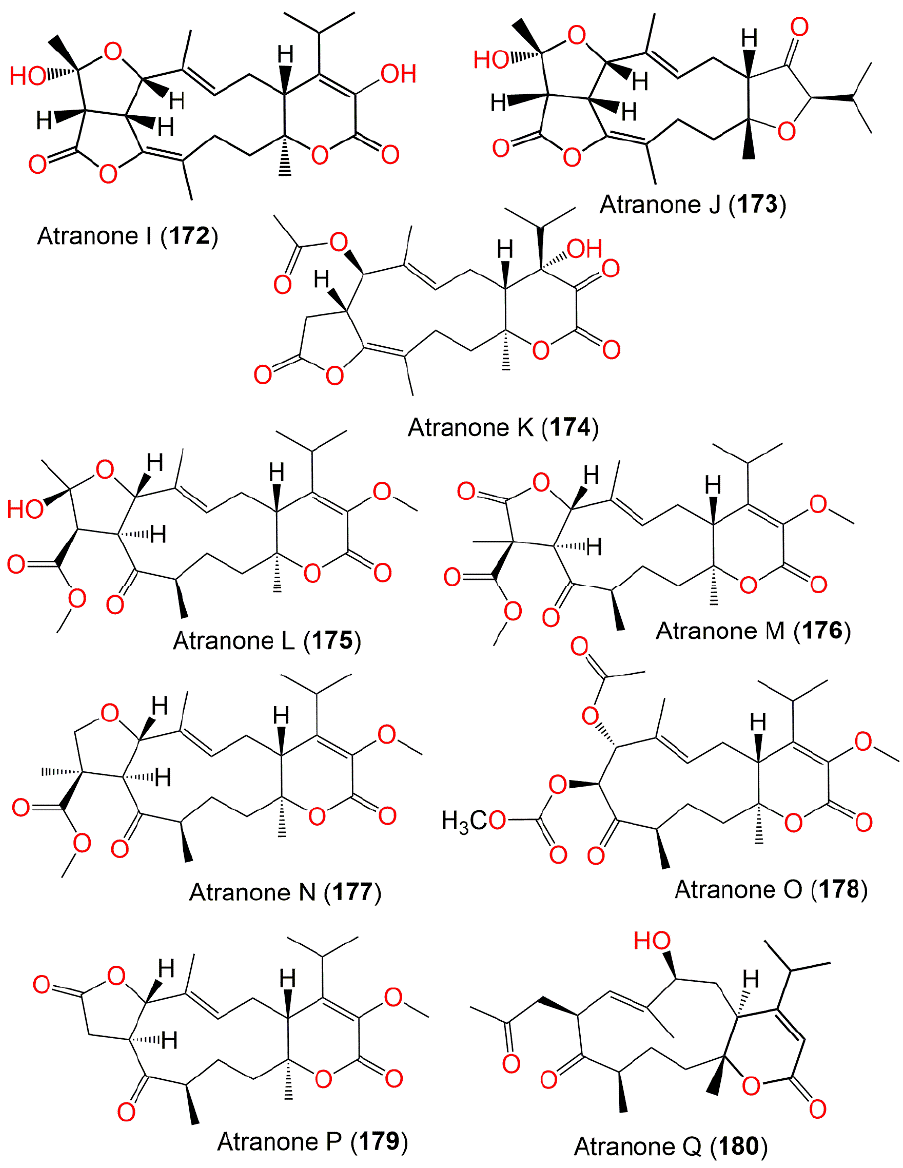
Figure 22. Structures of atranones ( 172 – 180 ) reported from S. chartarum .